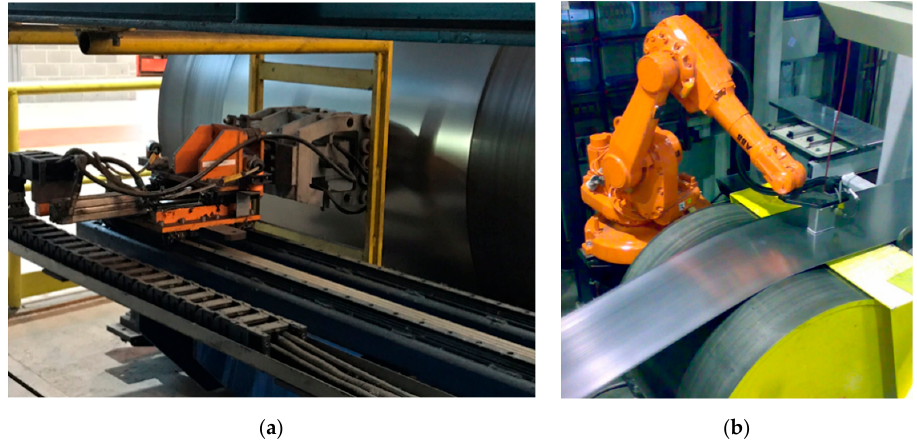
Figure 14. Further variants of 3MA probe head application on the running strip: ( a ) on a large deflection roller and ( b ) guided by a robot.